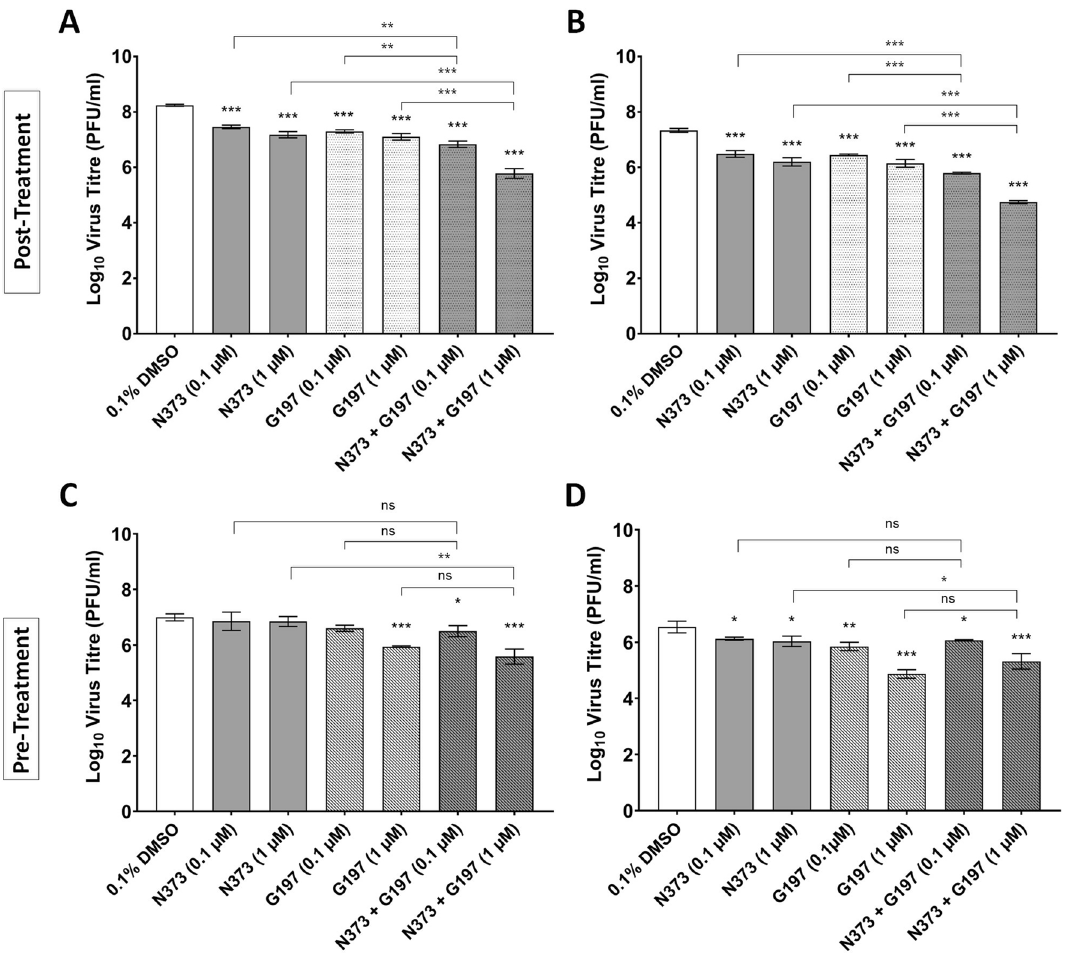
Figure 4. Treatment with both N373 and G197 exhibited greater inhibition of EV-A71 replication compared to single compounds when cells were treated after virus inoculation and not before. RD cells treated with N373 and G197 at the indicated combinations and concentrations were infected with EV-A71 after compound removal. Combination treatment (N373 + G197) at both concentrations resulted in virus titres lower than either of the single compound treatments at both MOI = 1 ( A ) and MOI = 0.1 ( B ). ( C ) RD cells were pre-treated for 2 h with N373 and G197 at the indicated combinations and concentrations prior to infection at MOI = 1 and ( D ) MOI = 0.1. Combination treatment did not result in a significantly lower virus titre compared to treatment with G197 only and N373 slightly reduced virus titres at a lower MOI. Statistical analysis for differences in virus titre due to drug treatment was performed with one-way ANOVA with Dunnett’s post-test: *( p < 0.05), **( p < 0.01), ***( p < 0.005). Student’s t-test was performed to compare single compound treatments (G197 or N373) to combination treatment at the same